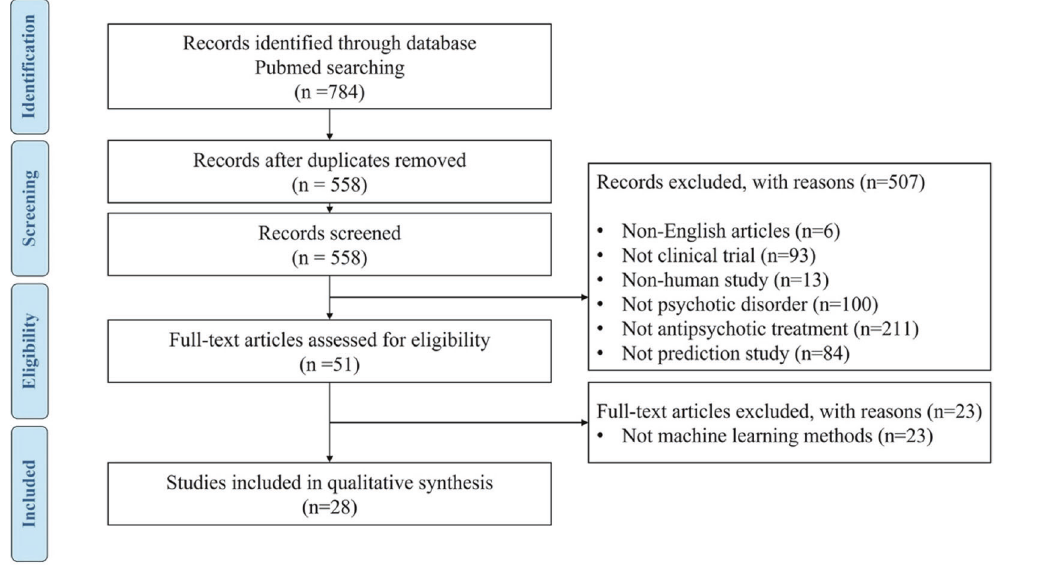
Fig. 1 Flow chart of study